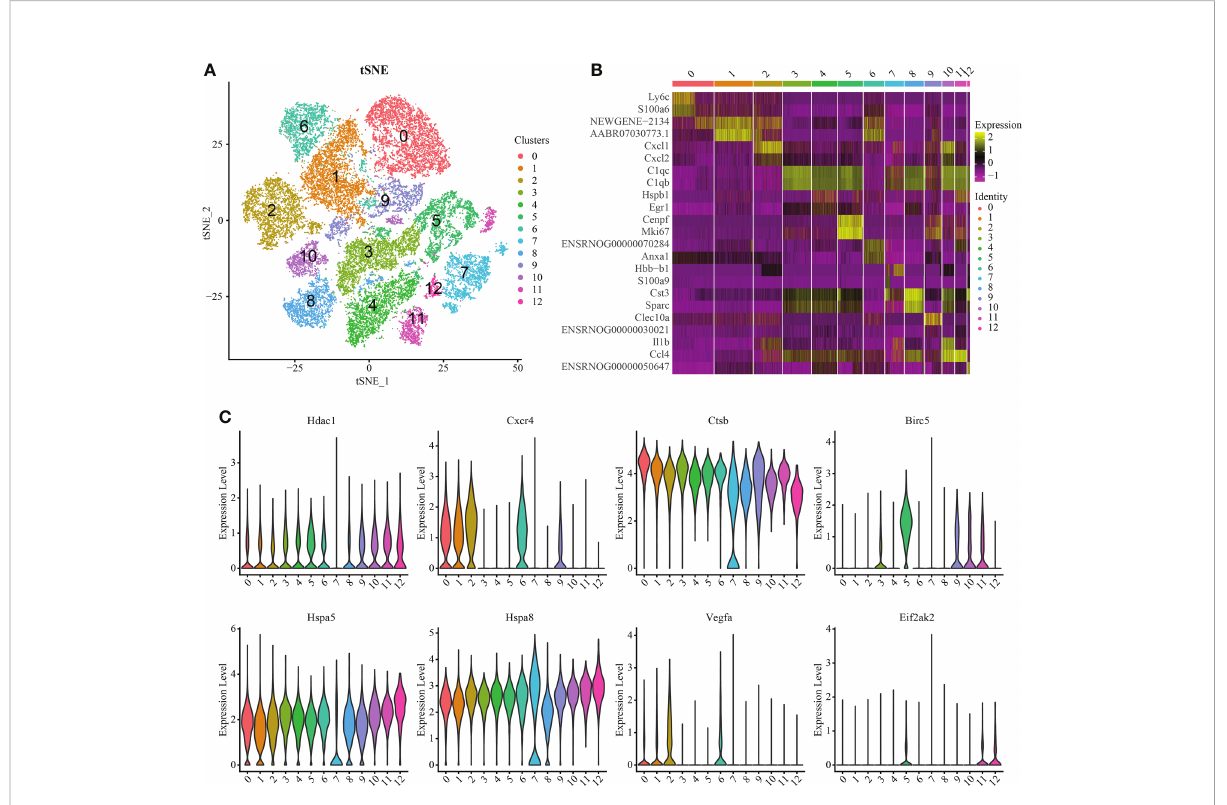
FIGURE 3 Macrophage/microglia subset analysis and pseudosequential analysis. (A) t-distributed stochastic neighbor embedding (t-SNE) distribution of different cell clusters. (B) Heat map showing the differential genes among each cluster, displaying the two most highly expressed genes of each cluster. (C) Violin map showing the expression pattern of IRAFs in macrophage/microglia